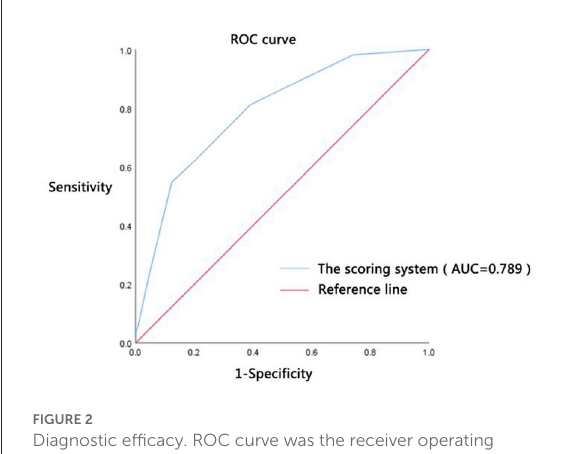
FIGURE2 Diagnostic efficacy. ROC curve was the receiver operating characteristic curve; AUC was the area under the ROC curve; the scoring system was constructed by the highest HR ≥ 105 beats/min (1 point), Lac ≥ 5.75 mmol/L (two points), PCT